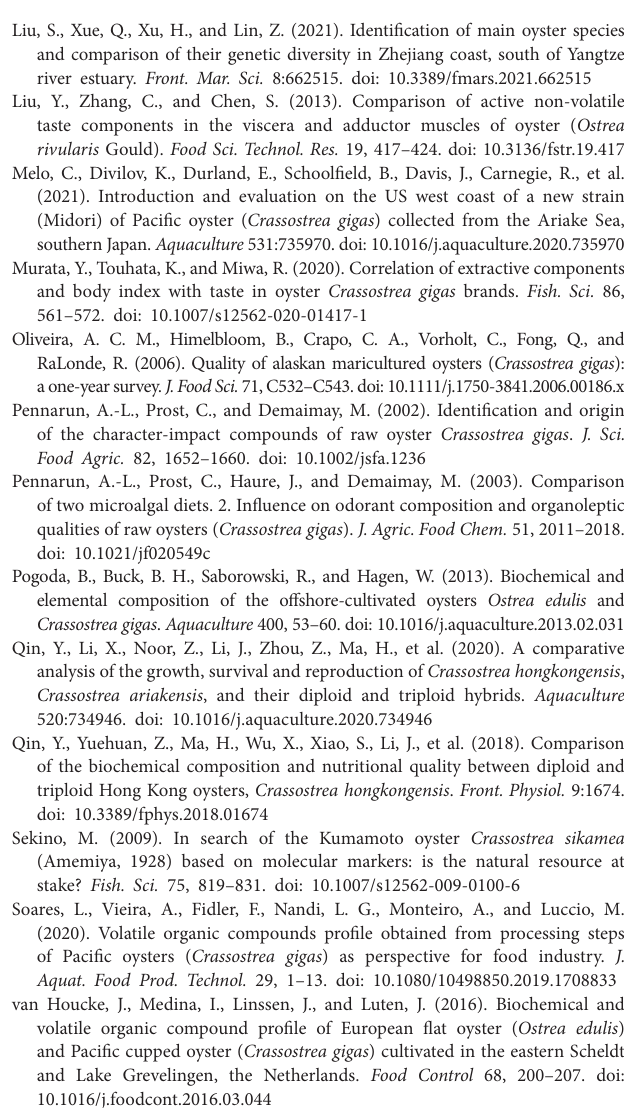
Supplementary Figure 1 | The flesh color comparison of Crassostrea sikamea and Crassostrea angulata in Xiangshan bay and species identification by molecular method. (A) The yellow-green flesh of Kumamoto oyster (left) and white flesh of Portuguese oyster (right). (B) Lane 1–4, specific bands for Portuguese oyster around 750 bp, lane 6–9, specific bands for Portuguese oyster around 660 bp, and lane 5: DL2000 DNA marker with the brightest band (750